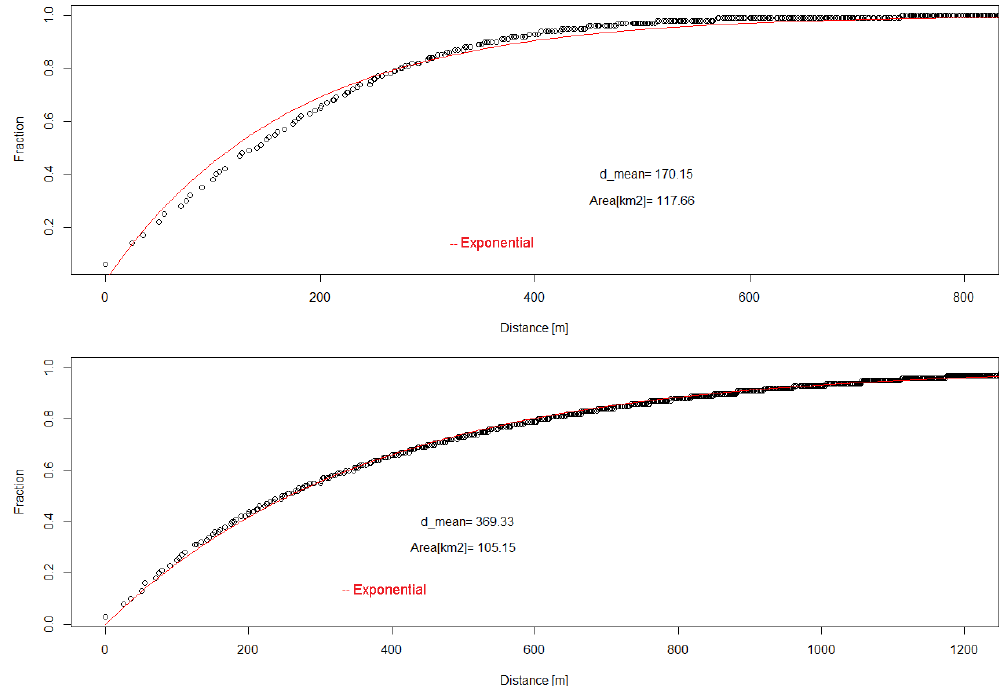
Figure 2. Empirical and fitted (exponential, red line) cumulative distribution functions (CDFs) of distances from a point in the catchment to the nearest river reach for two Norwegian catchments, Møska (top panel) and Narsjø (bottom panel). The catchments are located in the south and north-east, respectively, in southern Norway. The mean distance (denoted d_mean in the figure) and catchment size differ, but the shape of the distribution is